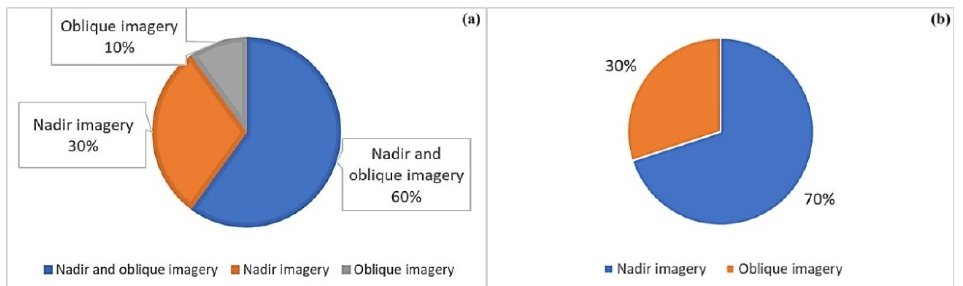
Figure 9. ( a ) Overall assessment of the accuracy of the photogrammetric products in accordance with UAV acquisition geometry using near distances; ( b ) assessment of the accuracy of the photogrammetric products using near distances between nadir- and oblique-viewing geometry.